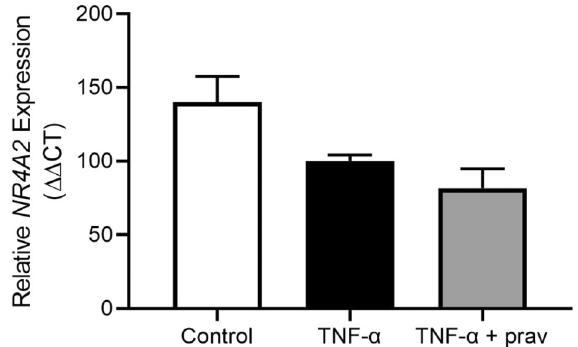
Figure 7. NR4A2 expression in human umbilical vein endothelial cells with TNF-α induced dysfunction, and pravastatin treatment. There was no significant change in NR4A2 mRNA expression with the addition of TNF- α. Pravastatin treatment did not alter NR4A2 expression from TNF-α only levels. The control group was not exposed to TNF-α. Data presented as fold change from TNF-α treatment ± SEM. n = 3 experimental replicates, with each sample from a different patient. Each experiment was run in